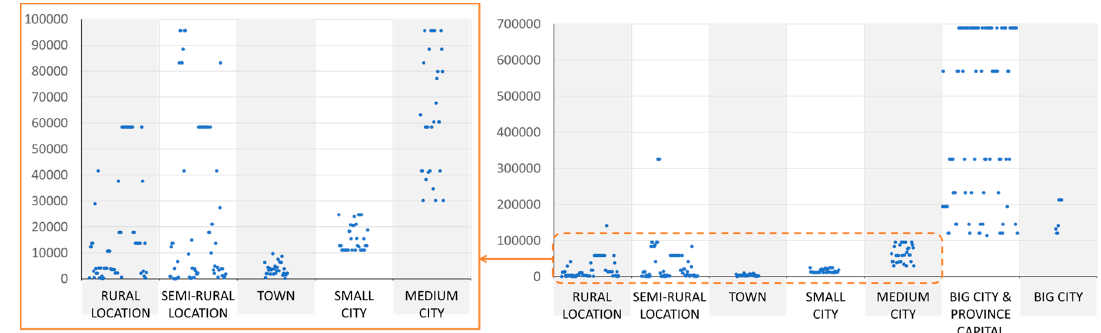
Figure 13. Distribution of assets within classification categories focused on the relationships with population centers by considering the number of inhabitants.